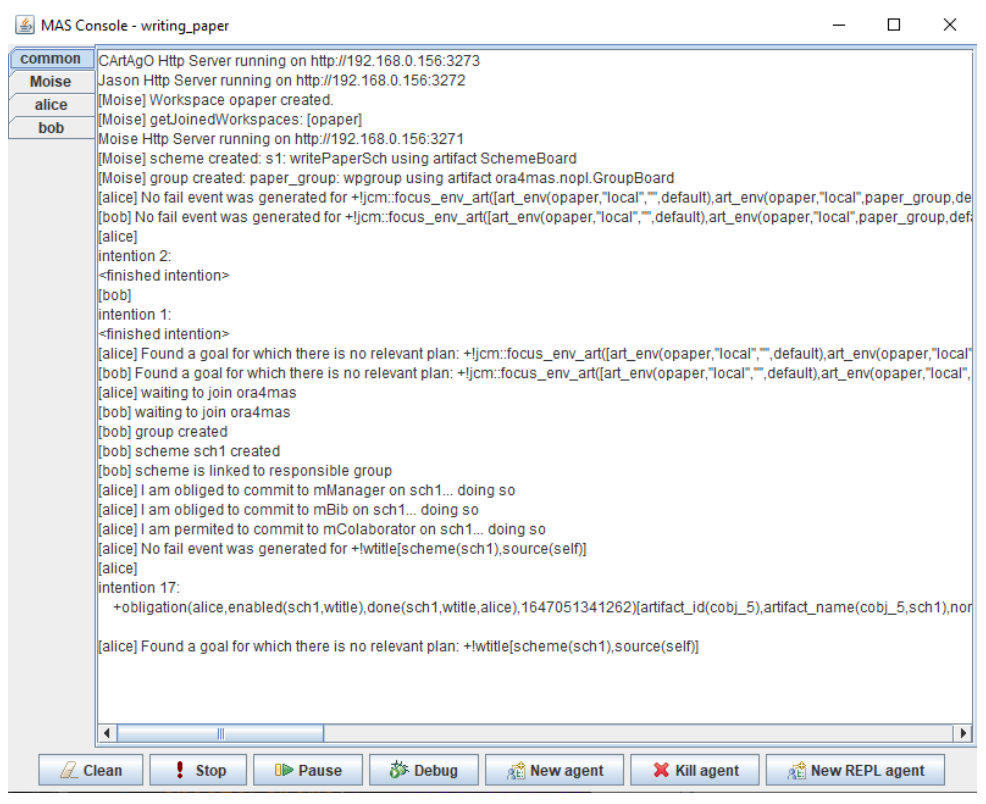
Figure 19. JaCaMo interface for simulation error example—obligation for an agent not eligible for the plan.